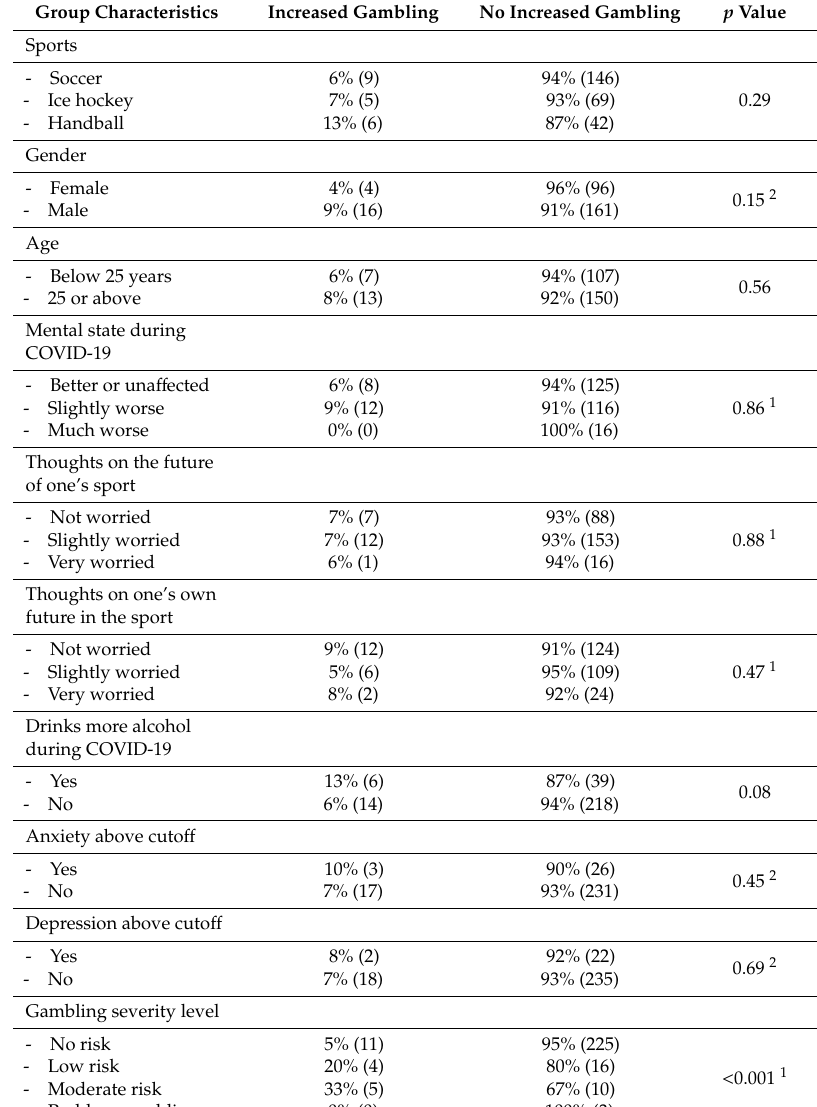
Table 5. Self-reported increase in gambling during the COVID-19 pandemic, depending on other variables. Chi-squared analyses for group comparisons.